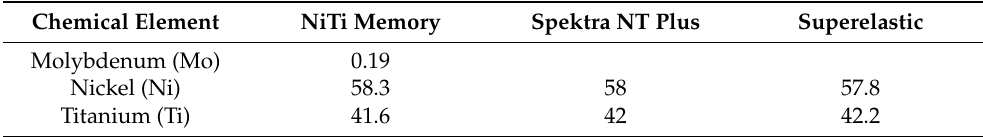
Figure 14. Superelastic archwire (Manufacturer 2) in side view: ( a ) before the test; ( b ) after the test. Table 12. XRF results of NiTi archwires. Percentages by weight.